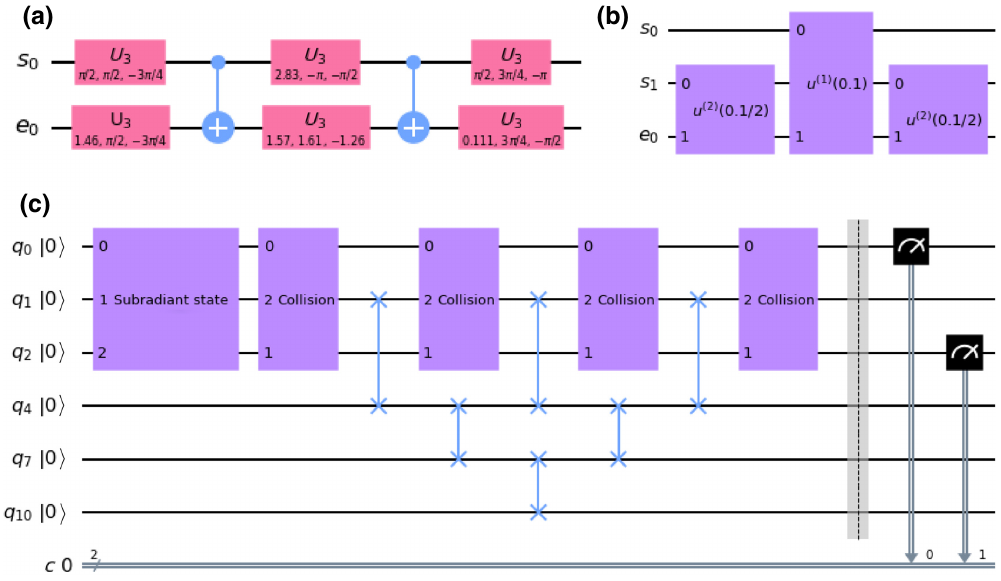
FIG. 7. (a) The decomposition of the gate U ( 1 ) ( 0.1 ) defined in Eq. (27) on the IBM quantum computer, applied on a system qubit s 0 and an ancillary qubit e 0 . The gates U 3 are single-qubit rotations defined by the three Euler angles given in the figure and are elementary gates available on the IBM quantum computers [45]. Two CNOT gates are also necessary to implement the system-ancilla interaction. (b) The scheme of a single collision of the MCM with (cid:11) t = 0.1 on the IBM quantum computer. The gates U ( 1 ) ( 0.1 ) and U ( 2 ) ( 0.1 / 2 ) are defined in Eq. (27) and their decomposition into elementary gates is given in (a). (c) The experimental circuit